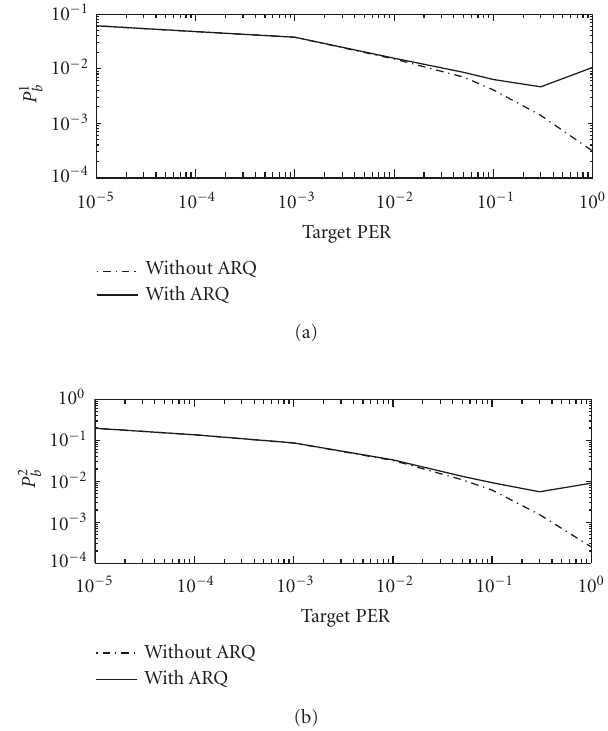
Figure 5: SMDP-based AC policy: blocking probability degradation in which L 1 = 0, L 2 = 1, and ρ as a function of ρ 2